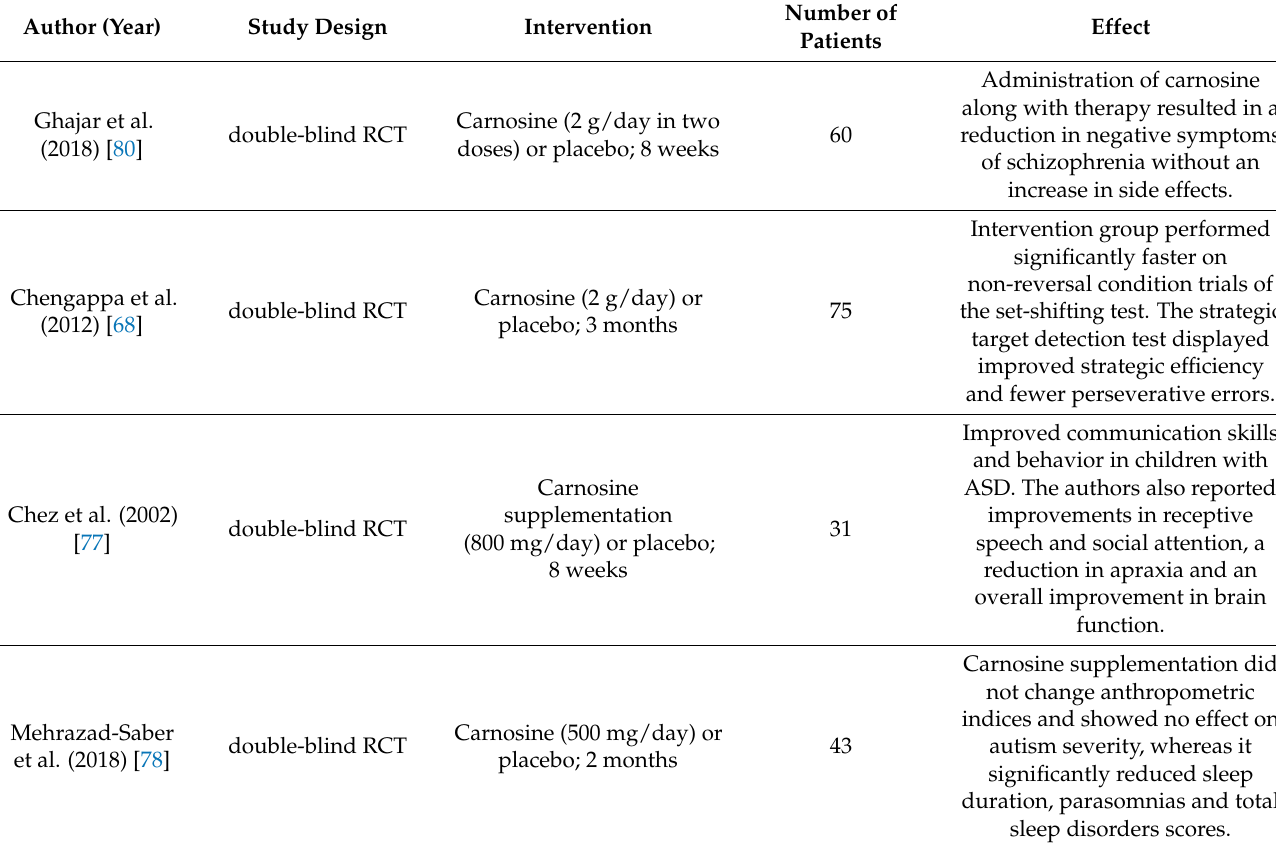
Table 3. Carnosine, beta-alanine and psychiatric diseases and their monitoring treatment